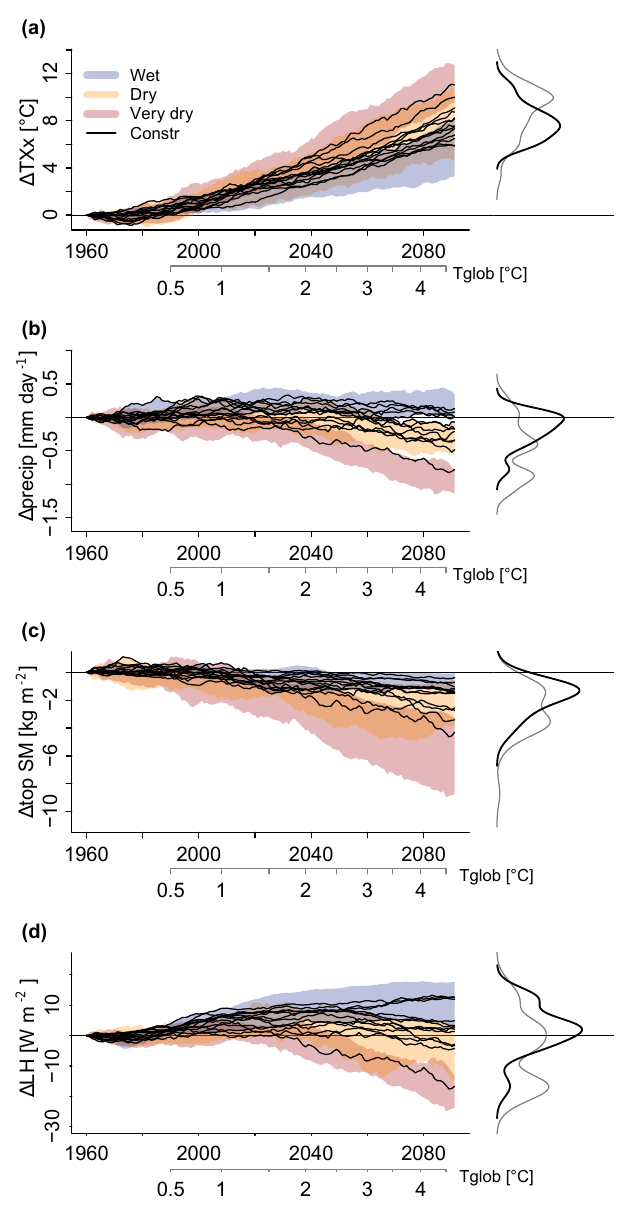
Figure 6. Changes in (a) TXx, (b) summer precipitation (precip), (c) top soil moisture (top SM) and (d) latent heat flux (LH) in CEU. Changes depicted as 20-year moving averages relative to the base period (1950–1969). The shaded areas cover the minimum and max- imum from the wet (blue), dry (orange) and very dry (red) models, respectively. The black lines show the changes of individual model runs of the constrained ensemble. Density distributions are shown for changes during 2081–2100 for the whole (grey) and the con- strained (green) ensemble